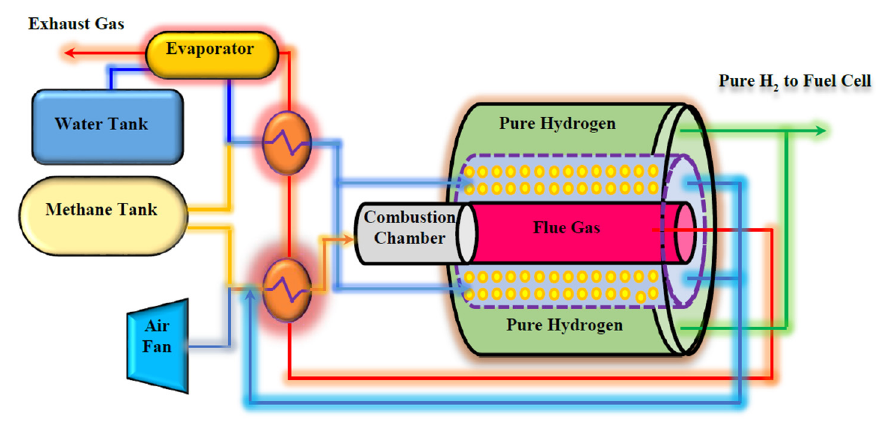
Figure 2. The proposed system for pure hydrogen producing in an on-board engine.